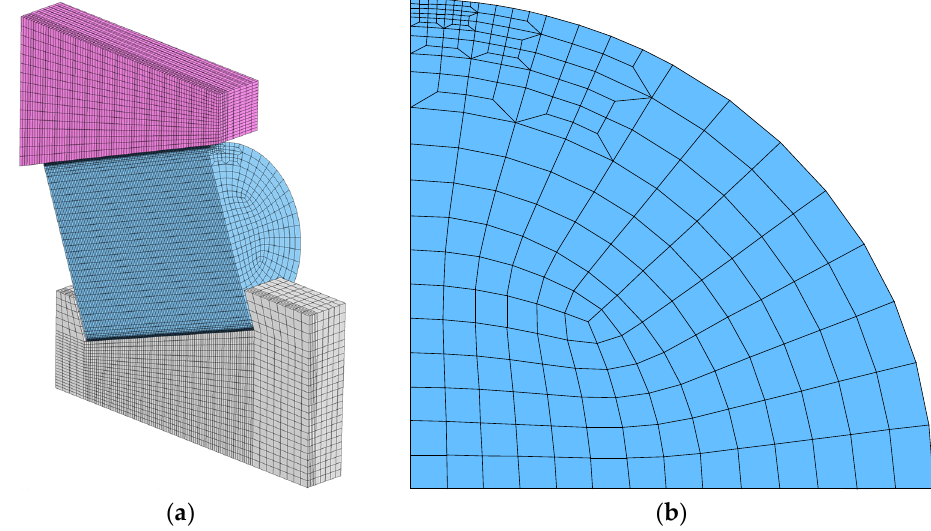
Figure 14. Mesh of the symmetric sub-model. ( a ) The mesh of sub-model; ( b ) The mesh of roller cross-section.